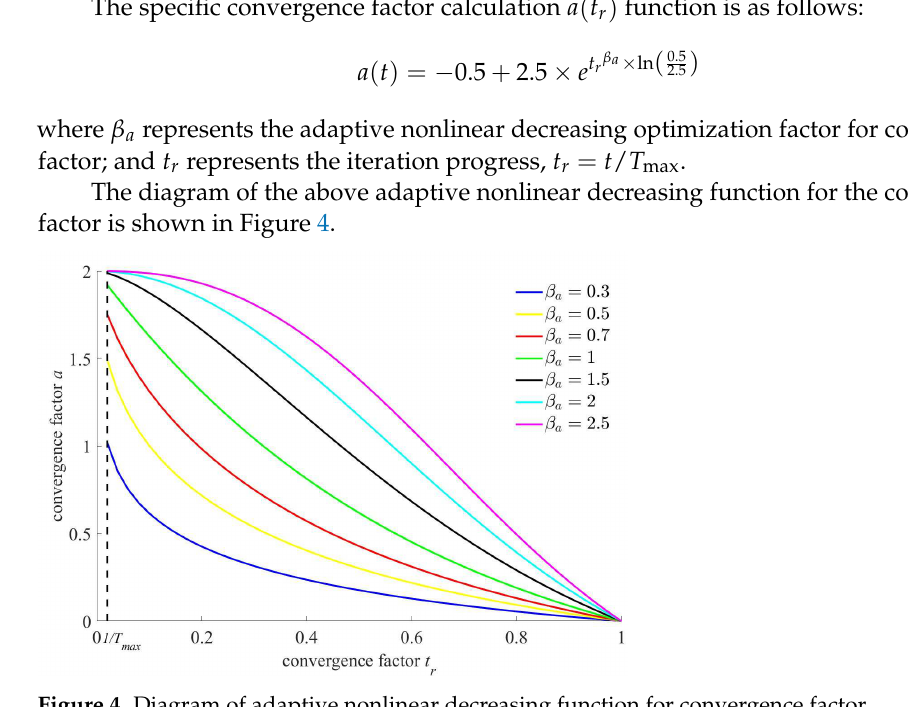
Figure 4. Diagram of adaptive nonlinear decreasing function for convergence